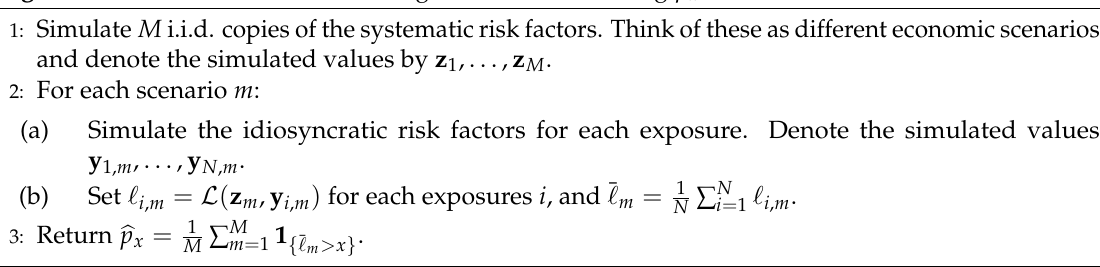
Algorithm 1 Standard Monte Carlo Algorithm for Estimating p